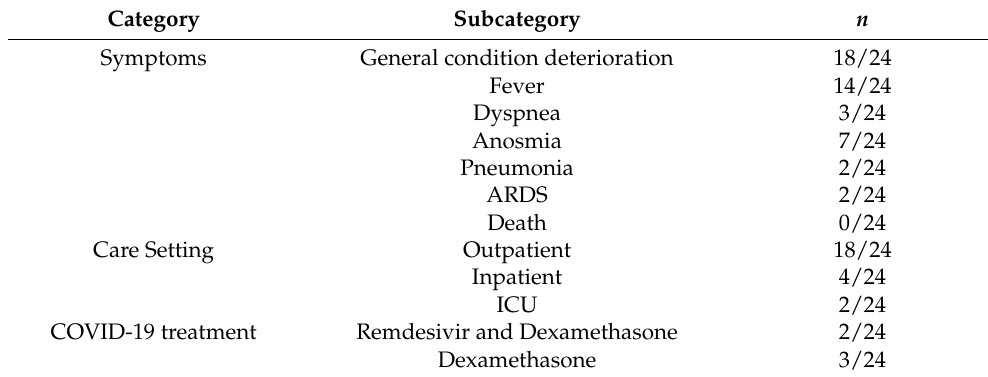
Table 2. COVID-19 course, outcomes and specific